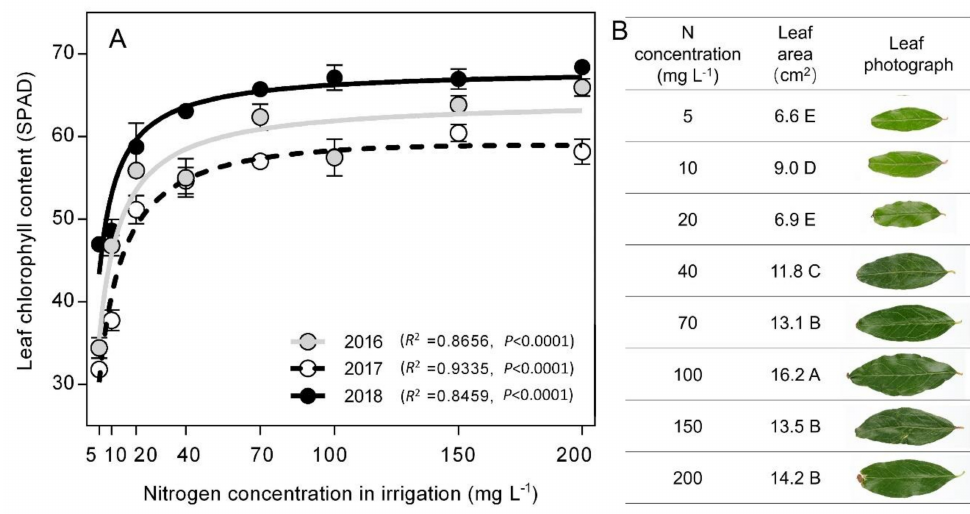
Figure 2. Leaf indices in pomegranate trees as a function of nitrogen concentration in the irrigation solution. ( A ) Leaf chlorophyll content; ( B ) leaf size and color in 2018. Bars represent SD. Di ff erent letters represent significant di ff erences between treatments at a given sampling date. Regression equations and statistics are presented in Tables A1 and